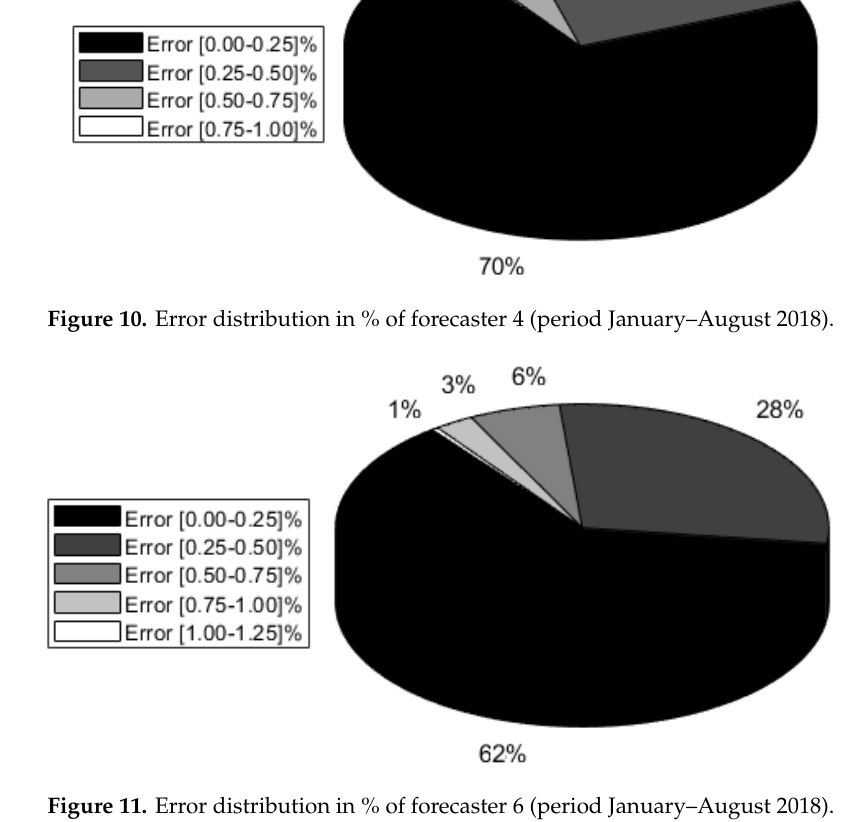
Table 12. Key parameters of the developed forecaster.